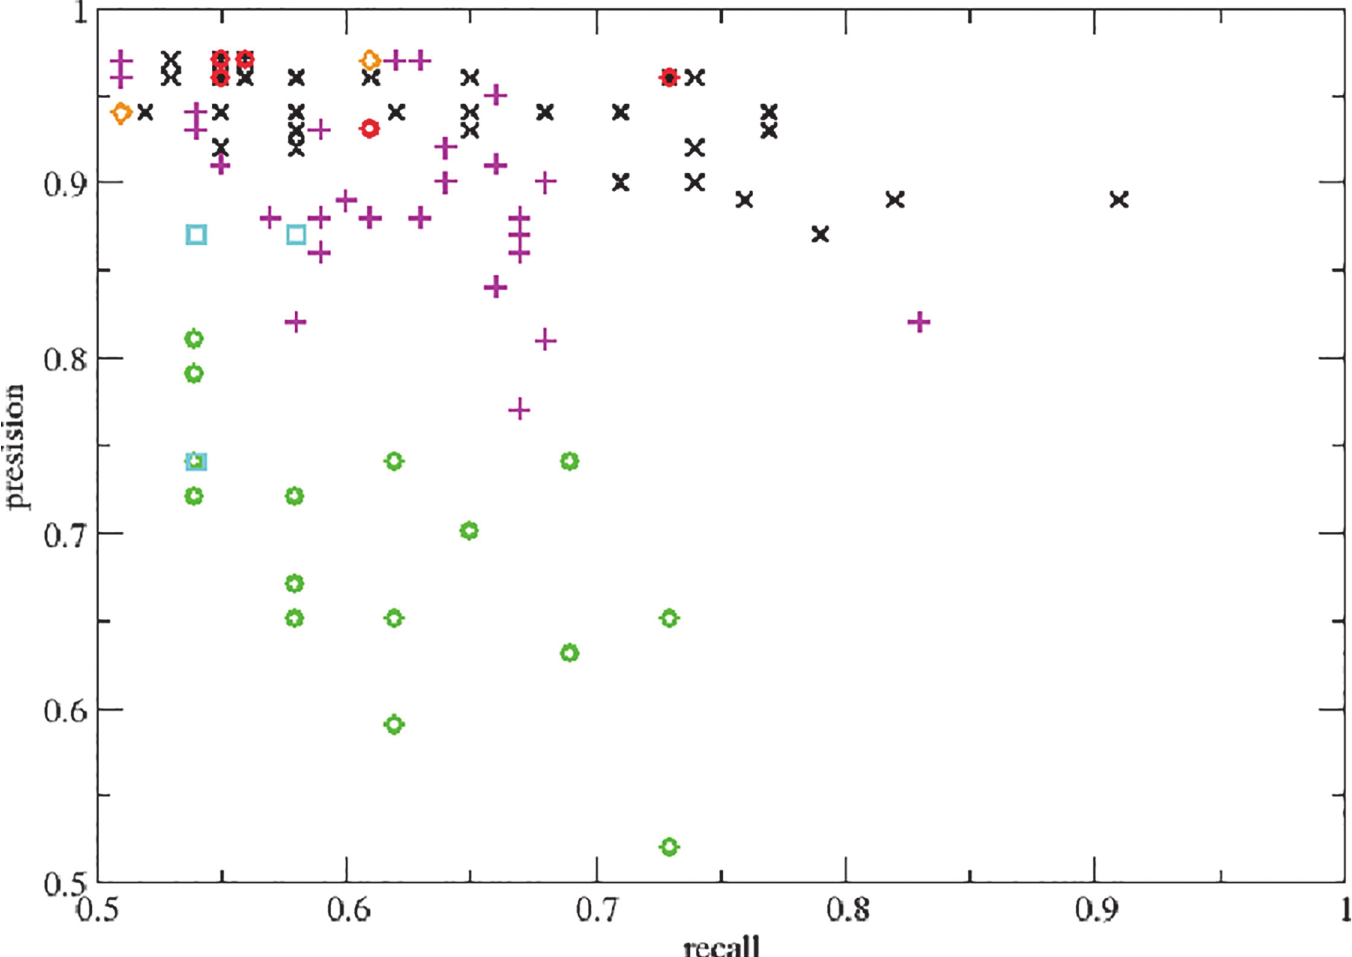
Fig 2. Pharmacophore results plot. 5 feature pharmacophore lab set (black x), 5 feature pharmacophore literature set (green circle), 5 featured combined set (magenta plus), 6 feature pharmacophore lab set (red circle), 6 feature pharmacophore literature set (cyan box) and 6 featured combined set (orange